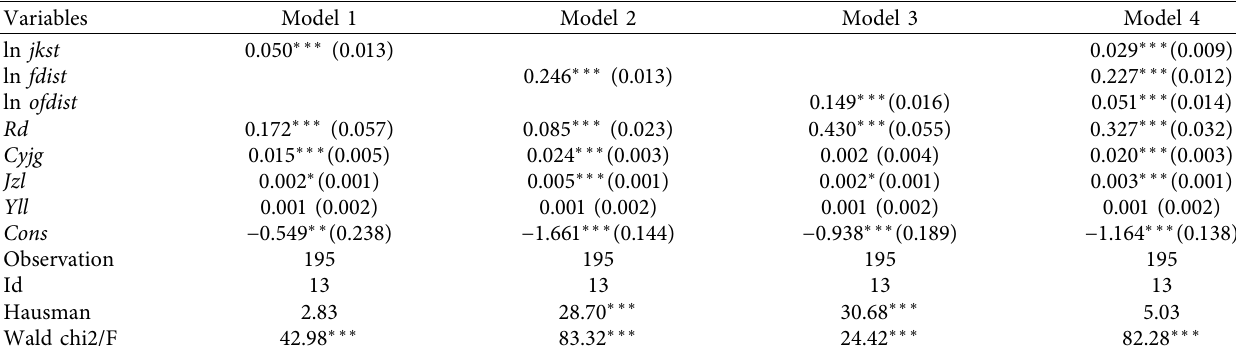
Table 3: Benchmark regression